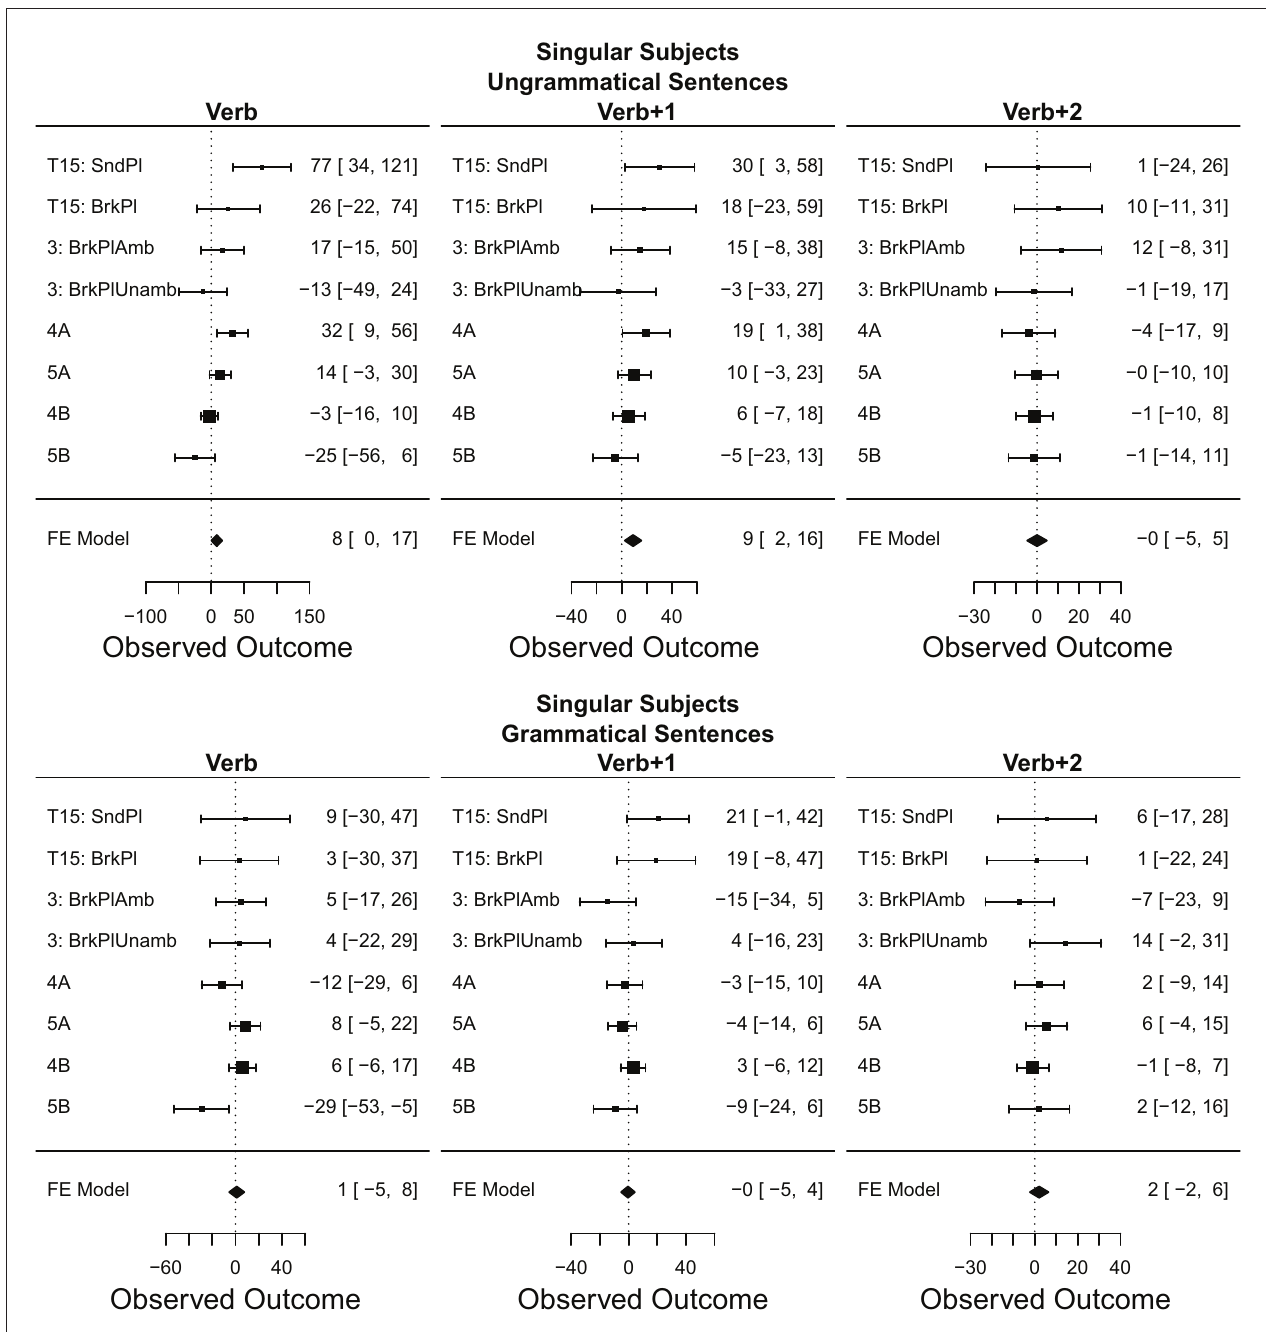
Figure 8 | Number effect in ungrammatical and grammatical sentences: forest plots of meta-analysis for singular subjects. The size of the square representing each experiment is proportional to its weight in the meta-analysis. The estimated effect size of the meta-analysis is represented by the black diamond at the bottom of each graph. The width of the diamond represents the estimated 95% CI of the meta-analysis effect size. Experiments are plotted in chronological order from top to bottom.